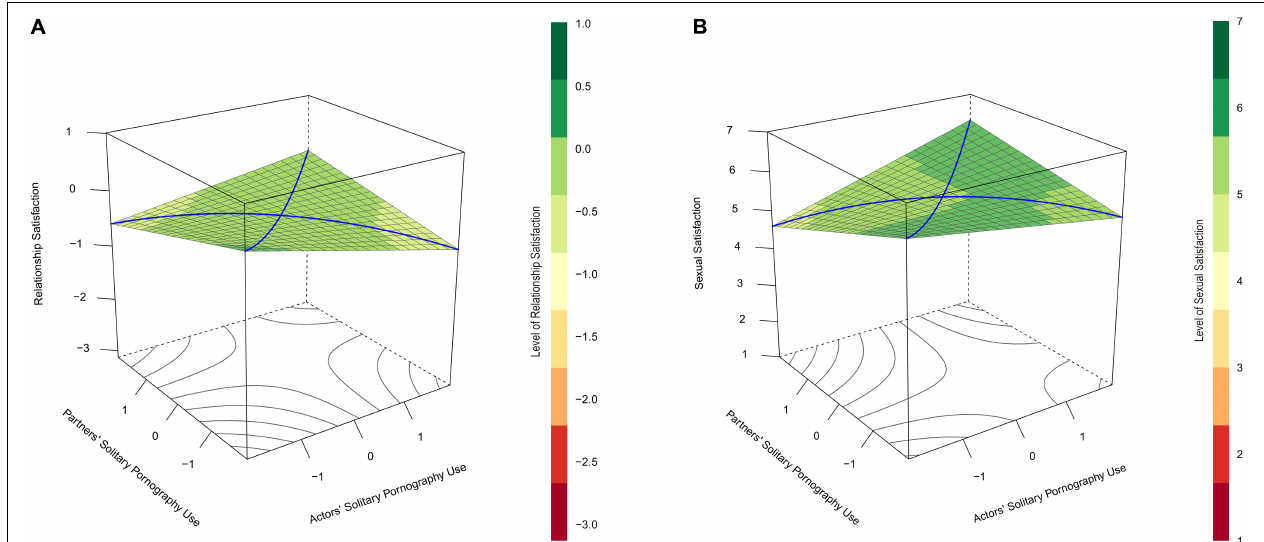
FIGURE 2 | (A) Depicts predicted relationship satisfaction (vertical axis) as a function of actors’ ( x -axis) and partners’ ( y -axis) frequencies of solitary pornography use and their interaction for cases that reported mean levels of shared pornography use in Study 1. (B) Does the same for the prediction of sexual satisfaction. In both cases, satisfaction scores tended to be lowest when couple members were most dissimilar in their solitary pornography use (left- and right-most corners of the plots), though this effect did not remain statistically significant when predicting relationship satisfaction (A) once gender was controlled for. With respect to sexual satisfaction (B) , a similarity-dissimilarity effect is evident: the curvilinear component of the line of incongruence was significant and region of significance tests indicated a participant’s own pornography use was negatively related to their sexual satisfaction, but only among participants who’s partners almost never used pornography (partners’ solitary pornography use <